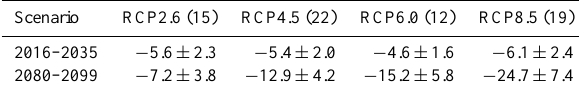
Table 2. Northern Hemisphere ice-free land (NH-ifl) seasonal snow cover change (in %, ± 1 σ inter-model spread) relative to 1986– 2005, for the four RCPs (march-april average). The number of mod- els taken in account in each scenario is given in parentheses after the scenario